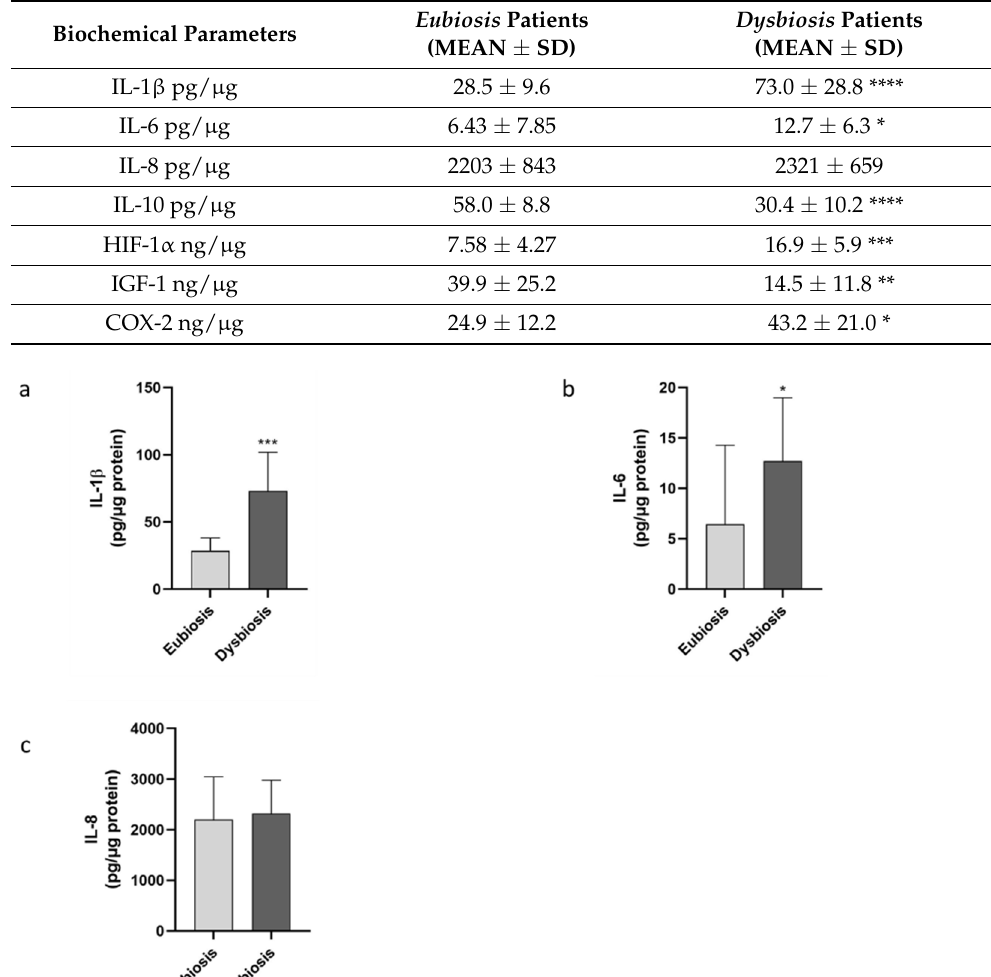
Table 4. Biochemical parameters measured in the two study groups. The data are expressed as mean ± SD. Statistical analysis was performed by unpaired t -test. * p < 0.05, ** p < 0.01, *** p < 0.001 **** p < 0.0001 vs. eubiosis patients.